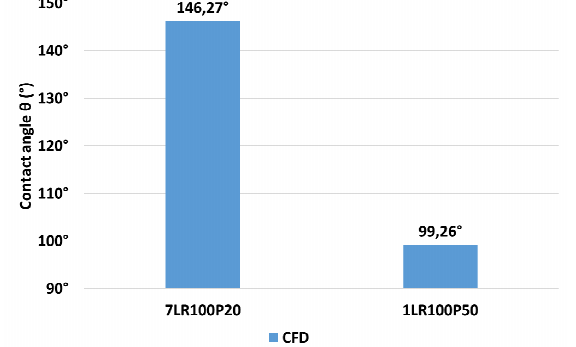
Fig. 9. Influence of the width of the grooves on contact angle (constant pitch R = 100 µ m).